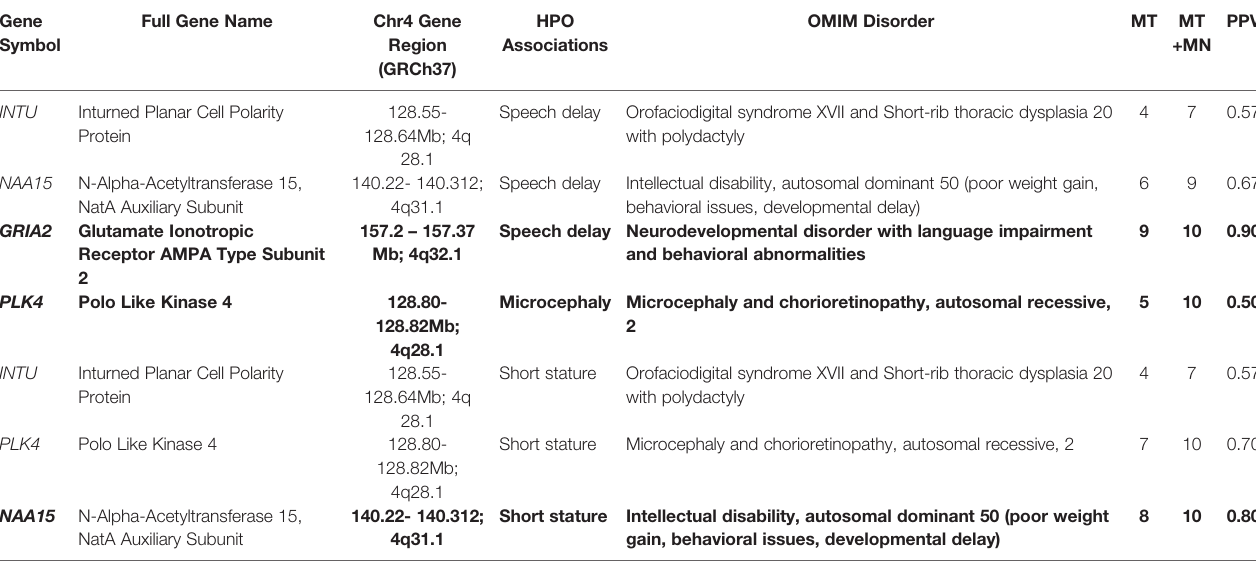
TABLE 2 | Data showing the candidate genes within the patient ’ s duplication region 4q 28.1-32.3 with the relevant associated HPO phenotype and OMIM